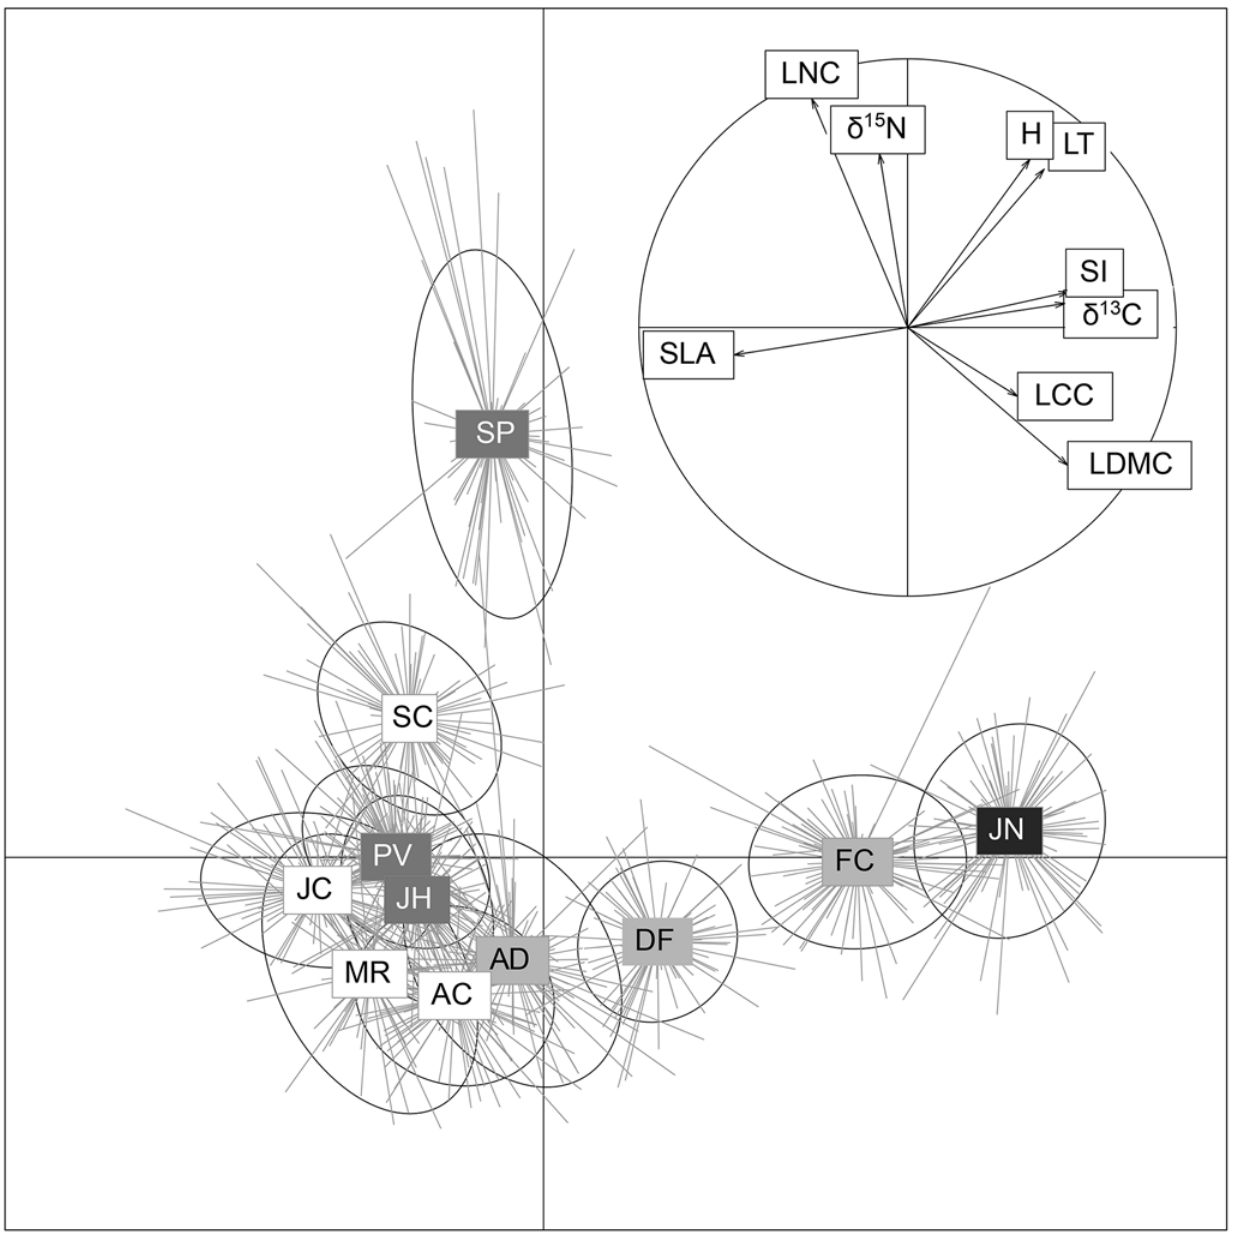
Fig 1. Principal component analysis (PCAs) using the nine traits measured in eleven species for a total of 856 individuals. The variability of individuals of each species and their distributions along trait axes is represented in the main PCA by lines that arise from species mean value and by an ellipse of dispersion. The minor PCA shows the correlation between the nine traits using all data. Species names are included by using acronyms and colour- coded by their growth form: (i) Hemicryptophyte (dark grey): PV ( Pilosella vahlii ), SP ( Senecio carpetanus ), JH ( Jurinea humilis ); (ii) cushion chamaephyte (white): AC ( Armeria caespitosa ), JC ( Jasione crispa ), MR ( Minuartia recurva ), SC ( Silene ciliata ); (iii) caespitosous hemicryptophyte (light grey) FC ( Festuca curvifolia ), DF ( Deschampsia flexuosa ), AD ( Agrostis delicatula ); (iv) shrub (black) JN ( Juniperus communis subsp. alpina ). Acronyms for traits: plant size (IS), plant height (H), leaf thickness (LT), specific leaf area (SLA), leaf dry matter content (LDMC), leaf carbon content (LCC), leaf nitrogen content (LNC), carbon and nitrogen isotopes ratios ( δ 13 C and δ 15 N,